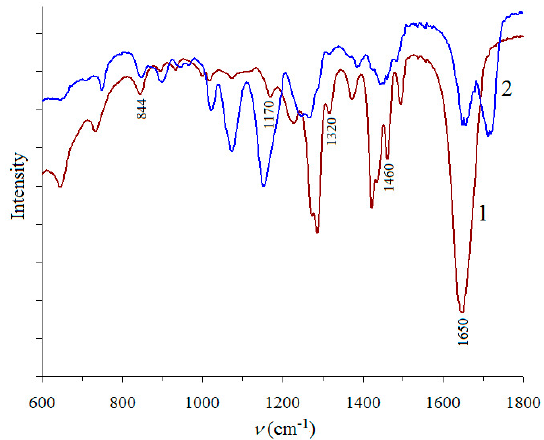
Figure 1. ATR FTIR spectra of PVP ( 1 ) and pHEMA-gr-PVP copolymer ( 2 ).